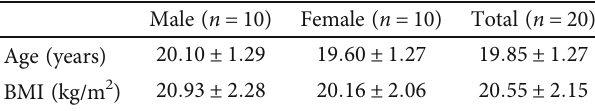
Table 1: Participant ’ s demographic